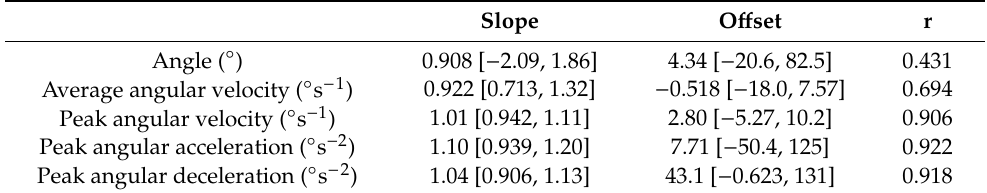
Table 3. Results of Passing–Bablok regressions performed on the computed parameters. Slope and O ff set are given with their 95% confidence intervals (between brackets).